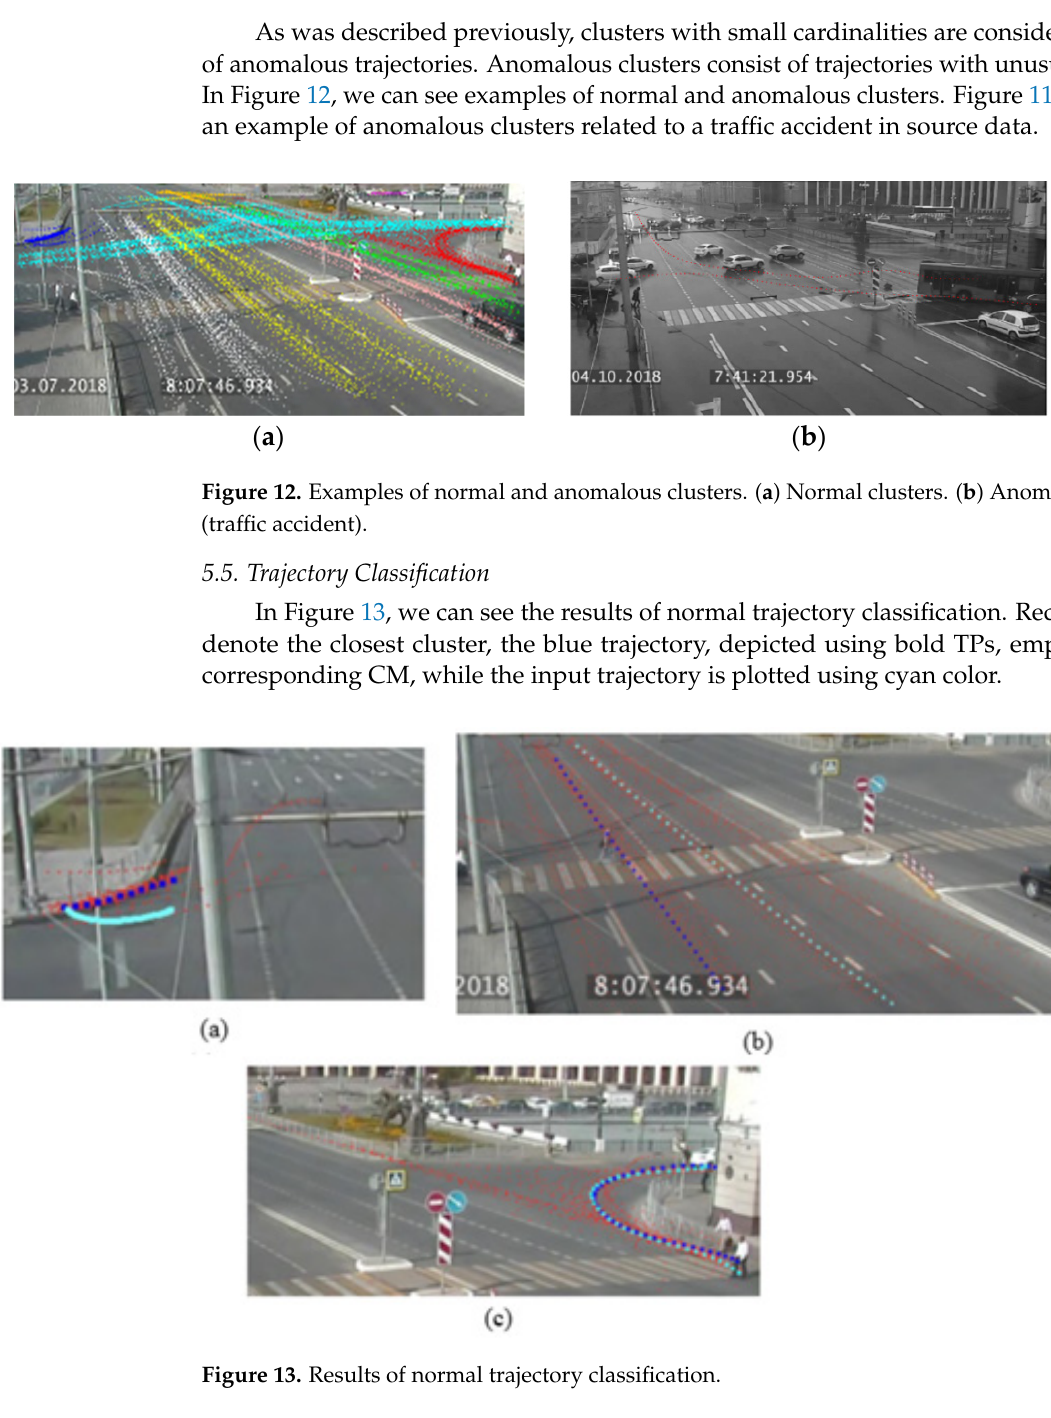
Figure 11. Clustering results ( a ) Polynomial regression, 11 clusters, DI = 0.94; ( b ) RDP N regression, N = 8, 11 clusters, DI = 0.95; ( c ) RDP N regression, N = 8, 9 clusters, DI = 0.93.